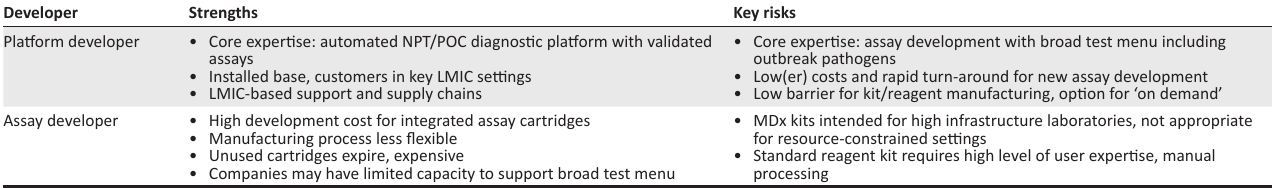
TABLE 2: Co-development leverage and risk